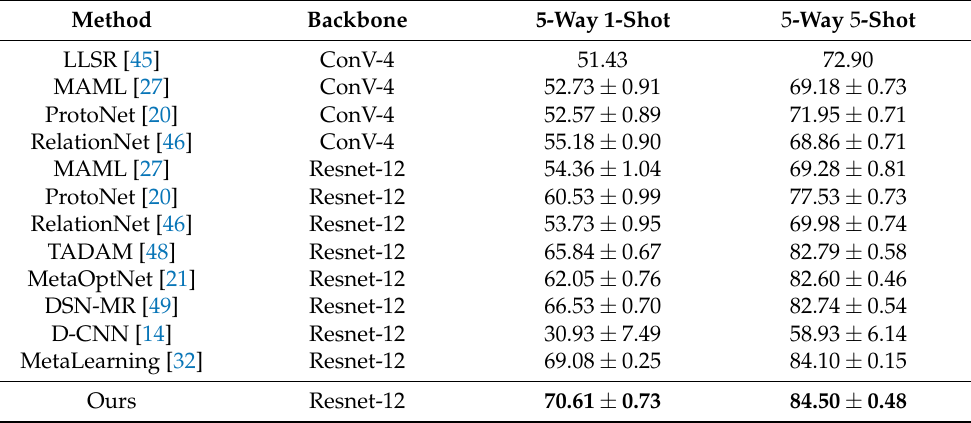
Table 3. The few-shot classification accuracies on the RSD46-WHU with 95% confidence intervals over 600 epochs.